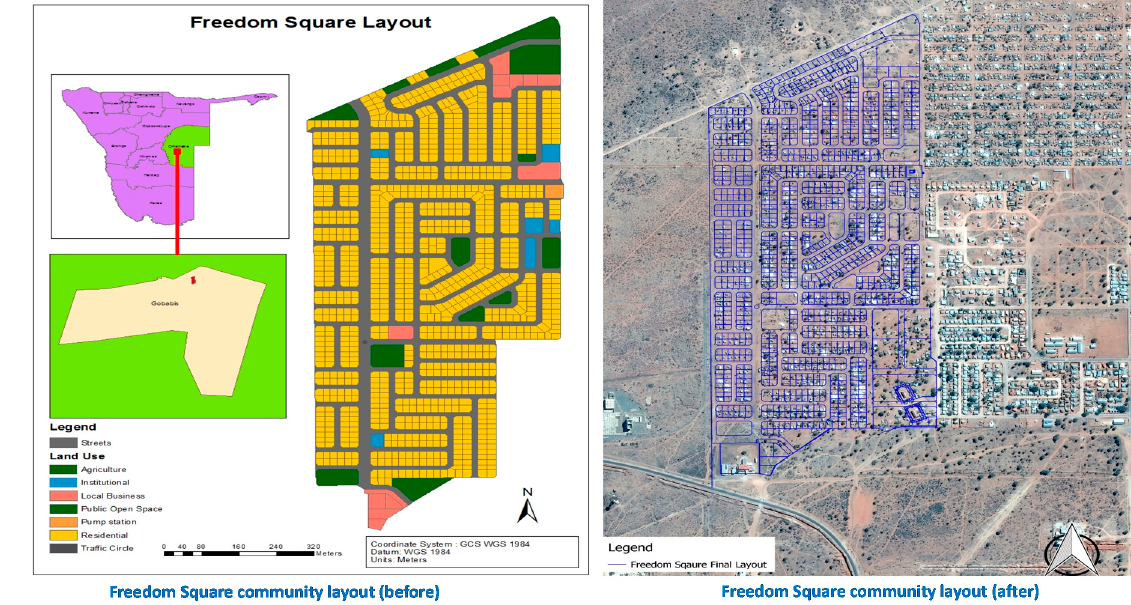
Figure 5. Freedom Square community layout (Source: Authors’).